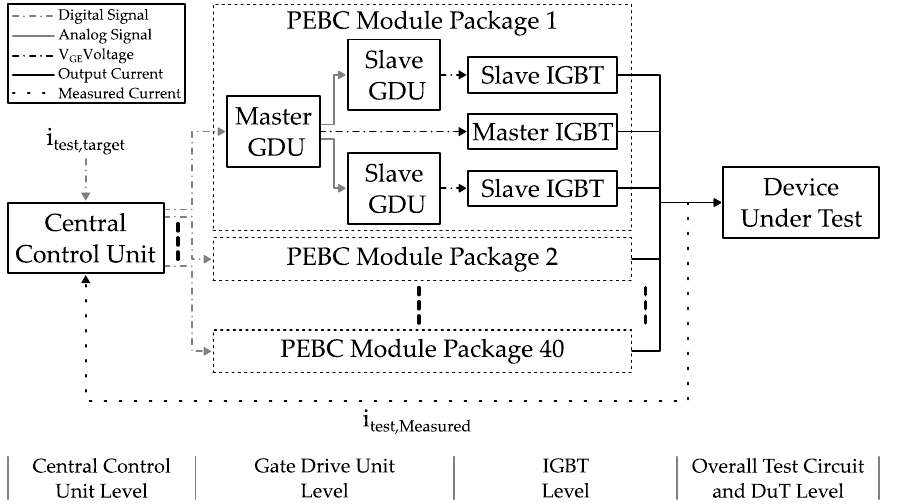
Figure 10. Schematic representation of the control structure and signal distribution of the demon- strator test circuit including digital and analog switching signals, V GE voltages, output currents and current measurement signals with one exemplary PEBC module package included in more detail.